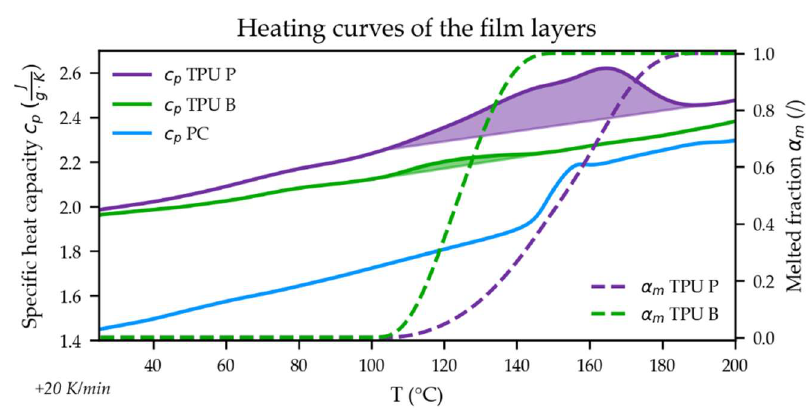
Figure 3. Specific heat capacity curves of the film materials. The melted fractions, α m , of the semicrystalline TPUs are depicted by the dashed lines.